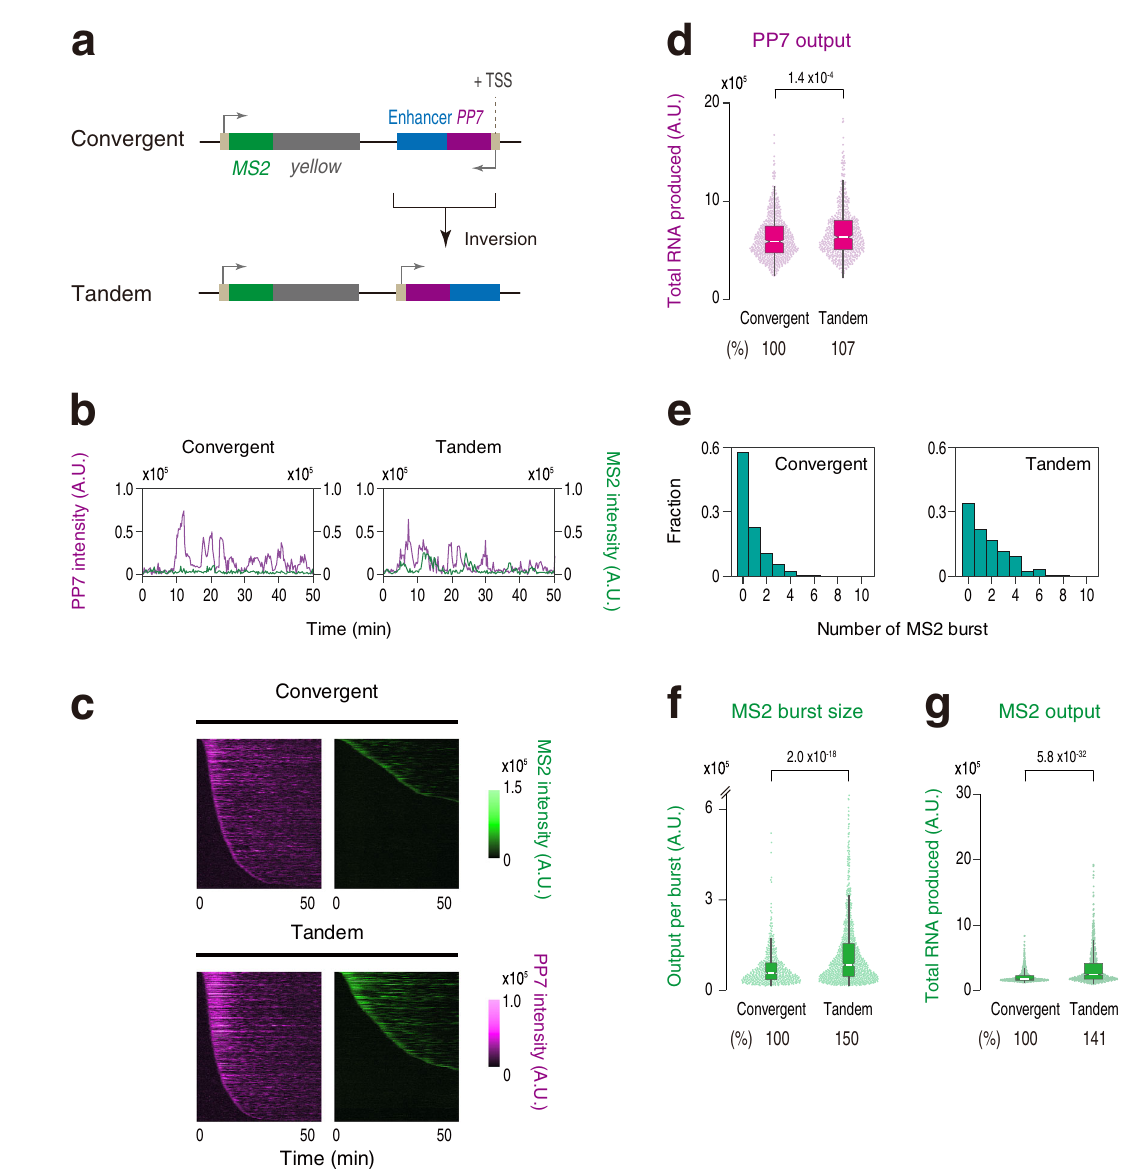
Fig. 3 | Non-coding enhancer transcription in a tandem orientation also sup- presses burst induction. a Transcribing sna shadow enhancer was placed in a tandem orientation relative to the MS2-yellow reporter gene. b Representative trajectories of transcription activities of the reporter locus driving non-coding enhancertranscriptioninaconvergent(left)oratandemorientation(right). c MS2 andPP7trajectoriesforalltheanalyzednuclei.EachrowrepresentstheMS2orPP7 trajectory for a single nucleus. A total of 719 and 638 ventral-most nuclei, respec- tively, were analyzed from three independent embryos for the reporter locus driving non-coding enhancer transcription in a convergent (top) or a tandem orientation(bottom).NucleiwereorderedbytheonsetofMS2orPP7transcription in nc14,separately. The samenumberof nucleiwereanalyzed hereafter. Apanelof Convergentisthesameasthepanelof+TSSshowninFig.1c. d Boxplotshowingthe distribution of the total output of PP7 transcription. The box indicates the lower (25%) and upper (75%) quantile and the white line indicates the median. Whiskers extend to the most extreme, non-outlierdatapoints. The plotofConvergent is the sameastheplotof+TSSshowninFig.1d. e Histogramsshowingthedistributionof